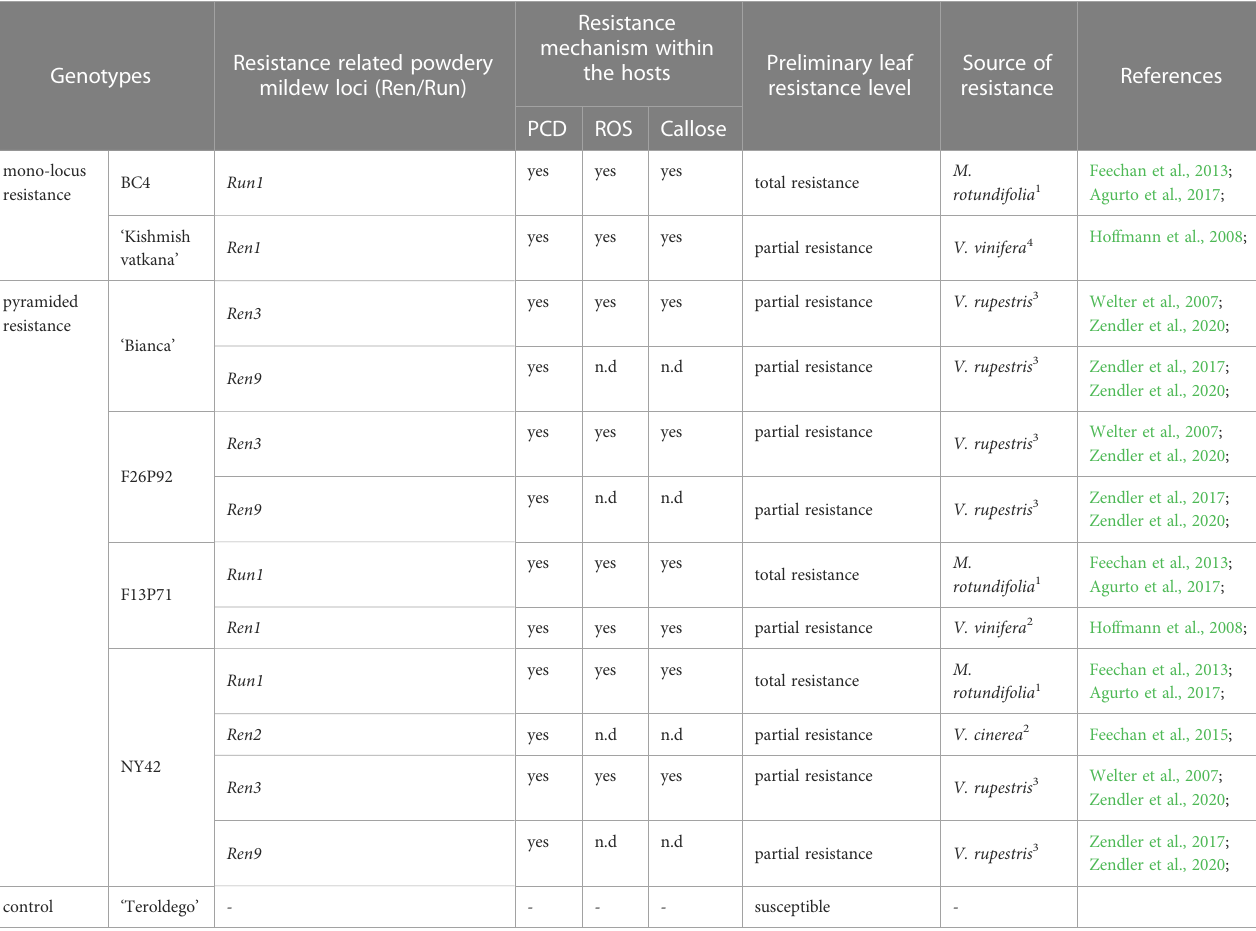
The levels of resistance described in the table: Total = greatly suppressed symptoms or the absence of visible symptoms; Partial = in cases where the symptomatology decreases without disappearing completely (Sosa-Zuniga et al., 2022; Julius Kühn-Institut,